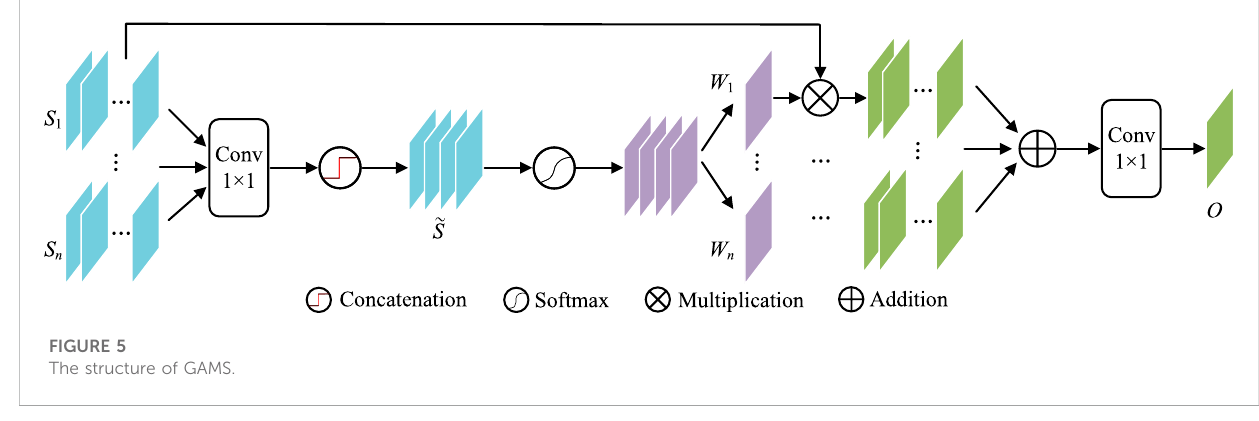
FIGURE 5 The structure of GAMS.